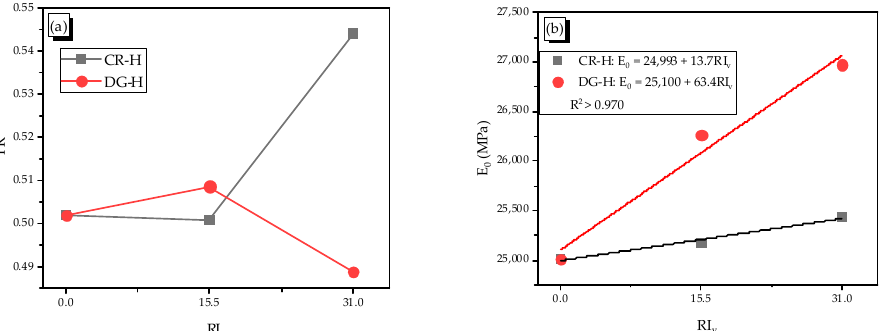
Figure 10. Relation of the reinforcing index–toughness ratio and elastic modulus in the heating case, ( a ) Relation between toughness ratio and reinforcing index in the heating case, ( b ) Relation between elastic modulus and reinforcing index in the heating case.